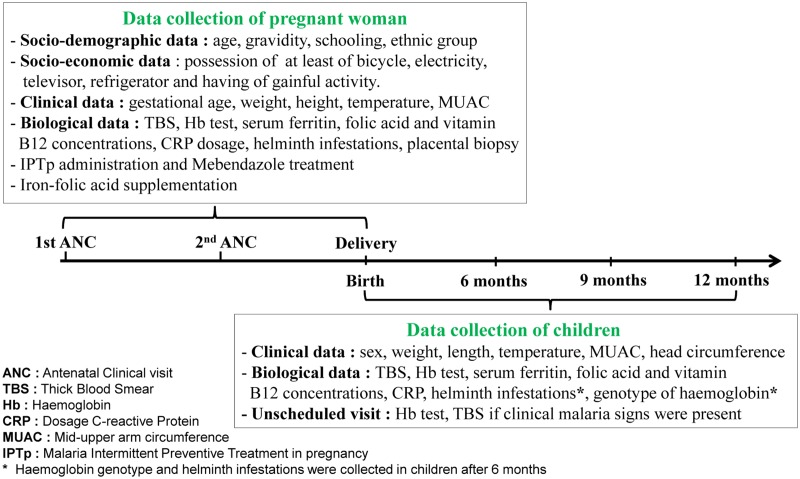
Study procedures.During follow-up, socio-demographic, economic, clinical and biological data were collected in mothers at 1st antenatal clinical visit (ANC), 2nd ANC and delivery. The same data were also recorded in infants at birth, 6, 9 and 12 months of life. Outside of scheduled visit, haemoglobin concentration and blood smear were performed when malaria signs were present.